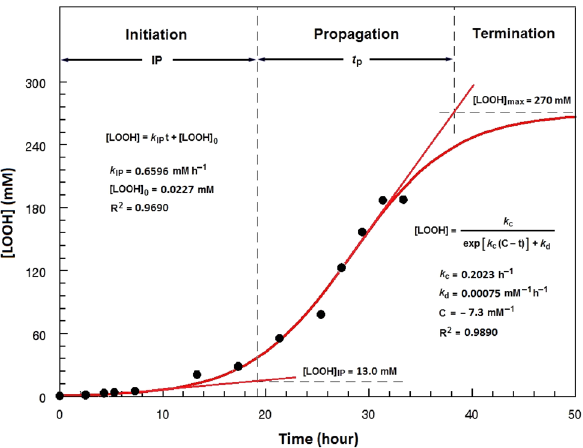
Figure 1. Kinetic curve of the accumulation of lipid hydroperoxides (LOOH) during peroxidation of the fish oil containing 1.2 mM of hydroxytyrosol at 60 °C, and the kinetic data from the linear and sigmoidal functions fitted on the initiation phase and the whole range, respectively, of the data points. IP induction period, t p duration of the propagation phase, [LOOH] 0 LOOH concentration at t = 0, [LOOH] IP LOOH concentration at IP, [LOOH] max the maximum concentration of LOOH, k IP the pseudo-zero order rate constant of the initiation phase, k